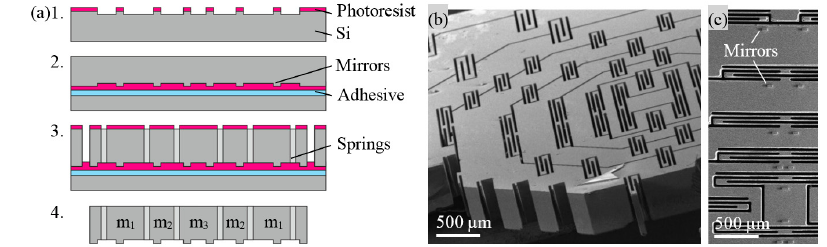
Figure 2. ( a ) Fabrication process flow: 1. Patterning of photoresist and dry etching of mirrors, 2. Photoresist protection of mirrors and mounting on carrier wafer, 3. Patterning of photoresist and through-wafer DRIE of springs, masses and dies, 4. Removal of dies from carrier wafer and cleaning with piranha; ( b ) SEM tilted top view of N7; ( c ) SEM back view detail with